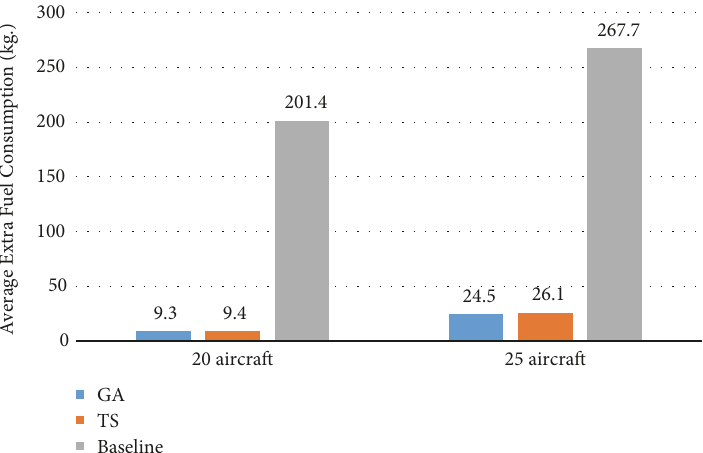
Figure 11: The average extra fuel consumption